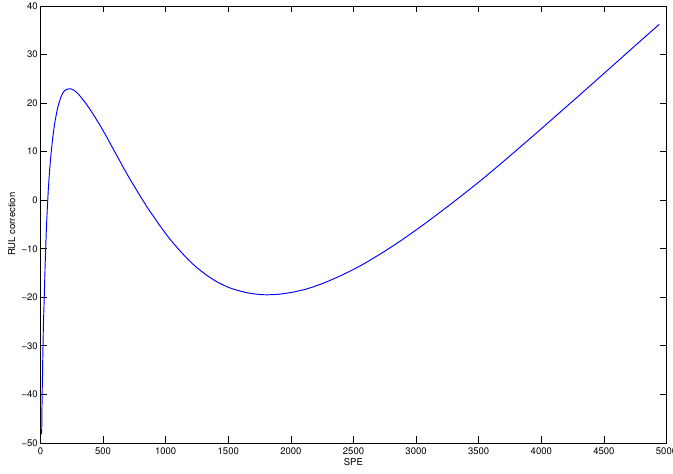
Figure 13. The error correction curve of SPE based prediction